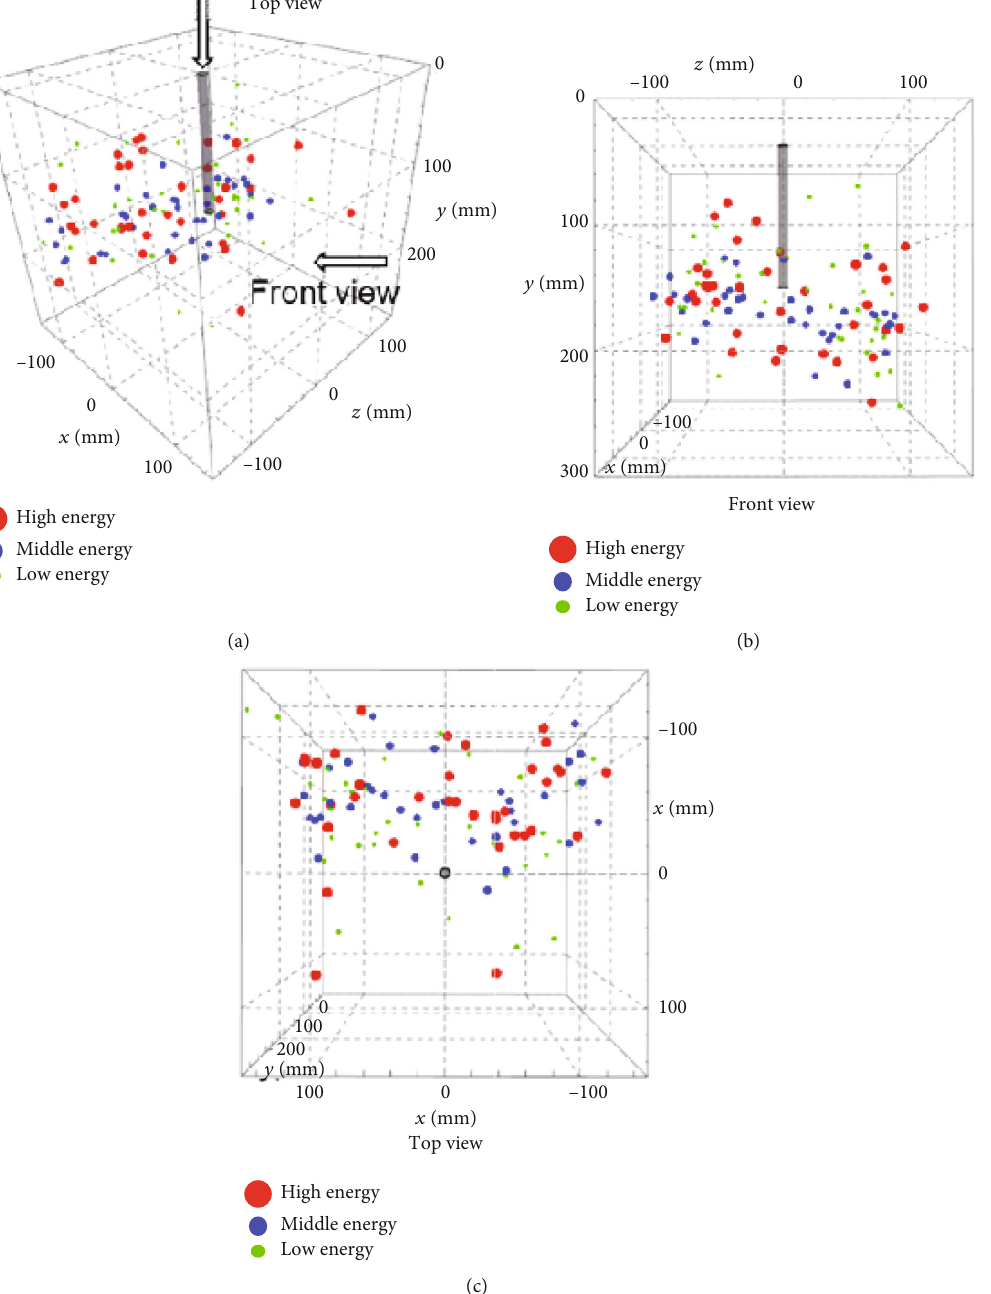
Figure 5: Di ff erent views of the AE localization of specimen